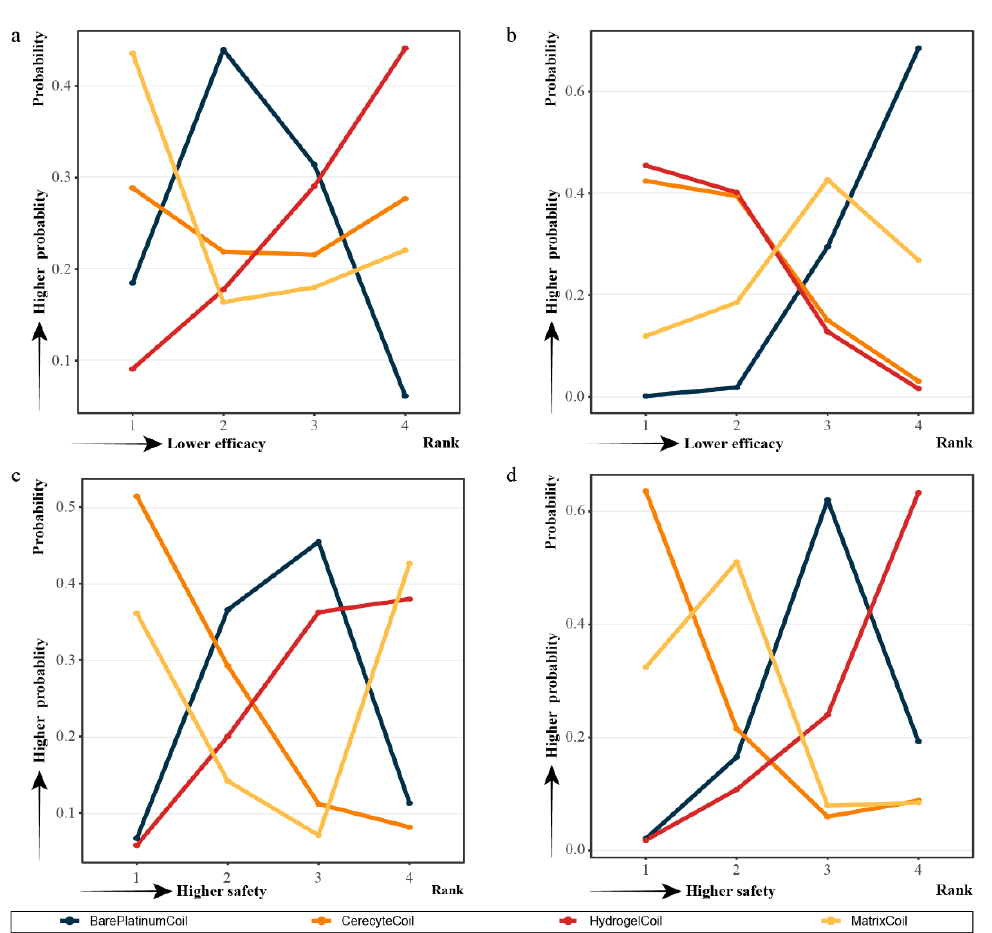
Figure 4. Probability ranks for outcomes of the efficacy and safety generated using fixed or random effect models. ( a ) Percentage of postoperative patients with modified Raymond scale grade I; (b ) Percentage of patients with modified Raymond scale grade I at follow-up; ( c ) Rates of intraoperative aneurysm rupture or re-rupture; ( d ) Mortality rate.